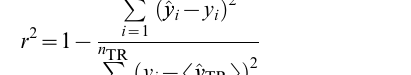
Figure 2. Superposed pharmacophore models. Superposition of three pharmacophore models Hypo A, Hypo B, and Hypo C, denoted in red, blue, and green, respectively.